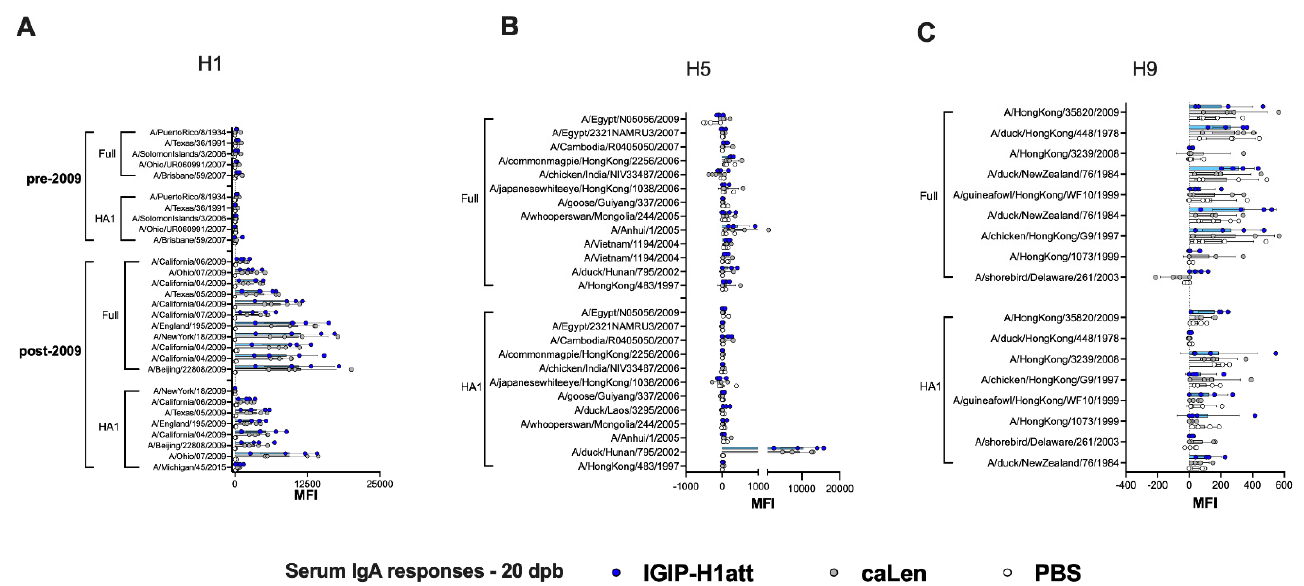
Figure 5 . IgA serum responses 20 dpb in IGIP-H1att- and H1caLen-vaccinated mice. Same set of samples from Figure 4 probed for IgA antibodies against ( A ) H1, ( B ) H5 and ( C ) H9 using the influenza antigen array. The reactivity of serum samples is expressed as described in Figure 4 and results shown as MFI ± SD. IGIP-H1att samples in blue dots/bars. H1caLen samples in grey dots/bars. PBS control samples in white dots/bars. No significant differences were observed.